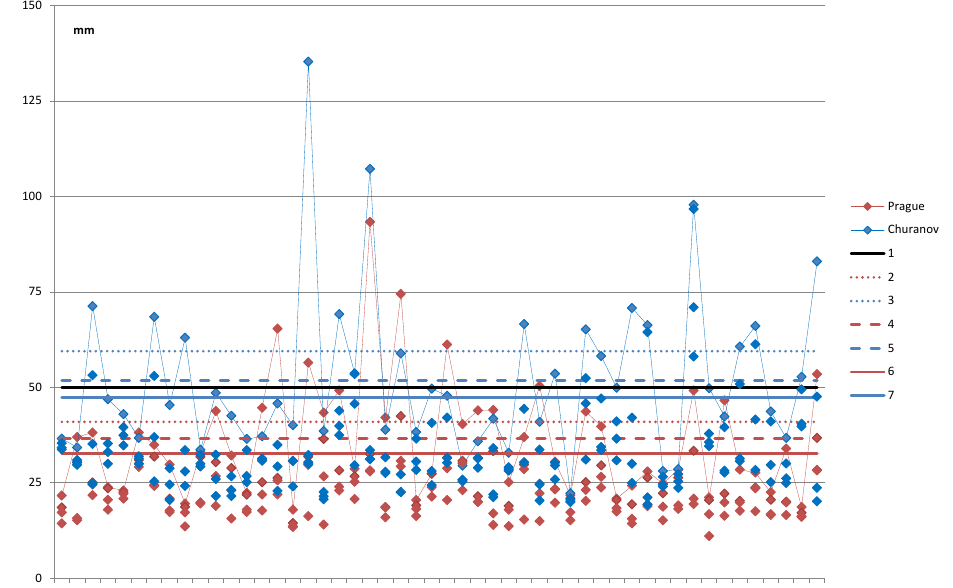
Fig. 1. Four highest daily precipitation totals per year during 1961–2010 in Prague-Ruzyne (364ma.s.l.) and in Churanov (a peak in Šumava mountains with a height of 1118m). Annual maxima are interconnected by thin lines. The thresholds discussed in the text are depicted by horizontal lines: precipitation total of 50mm (1), quantiles 99.9% in Prague-Ruzyne (2) and in Churanov (3), average annual maxima in Prague-Ruzyne (4) and in Churanov (5), and precipitation totals corresponding to the return period of 2yr in Prague-Ruzyne (6) and in Churanov